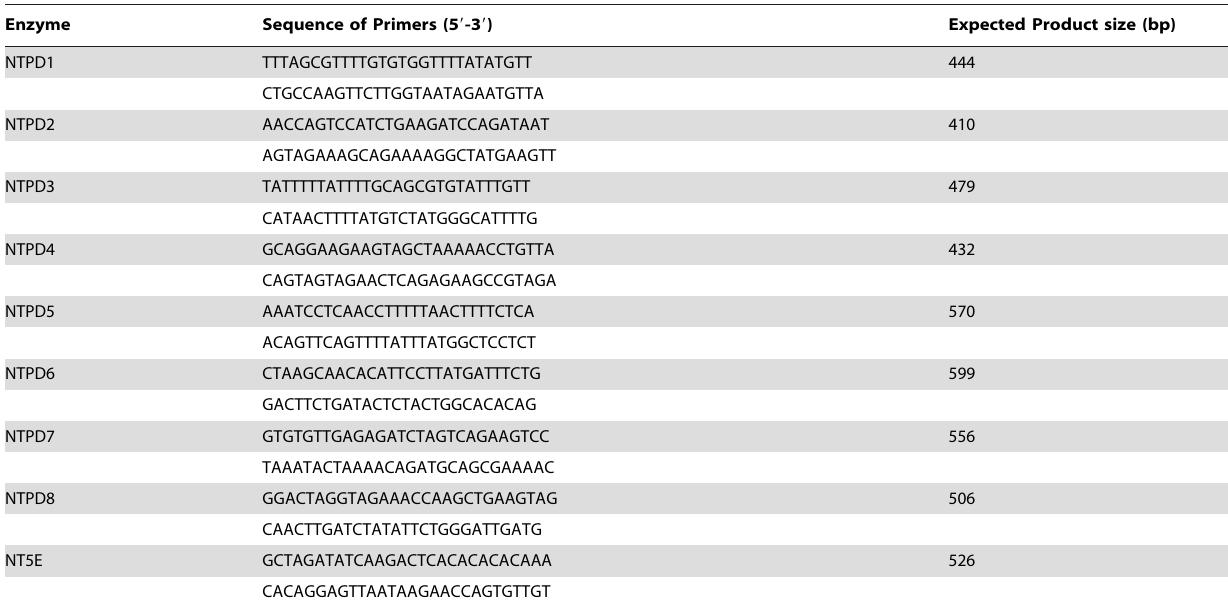
Table 1. Primers used for PCR of Nucleotidase Enzymes.